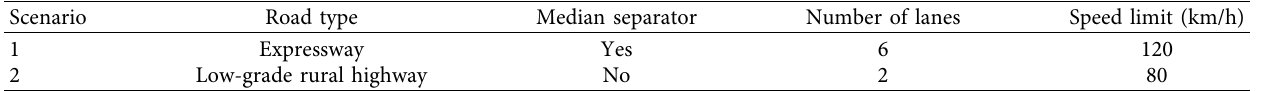
Table 1: Description of the driving scenarios.